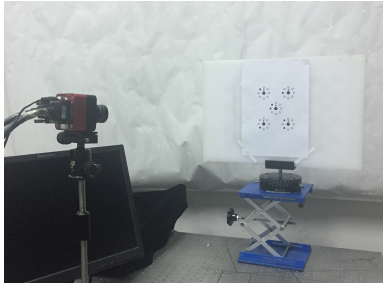
Figure 3. The verification experiments of coded mark